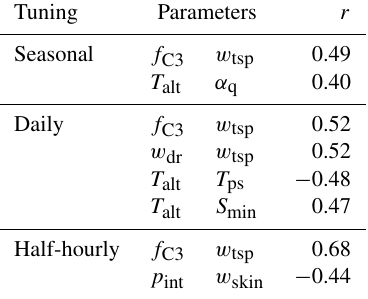
Table 2. The highest correlations between parameters. Tuning Parameters